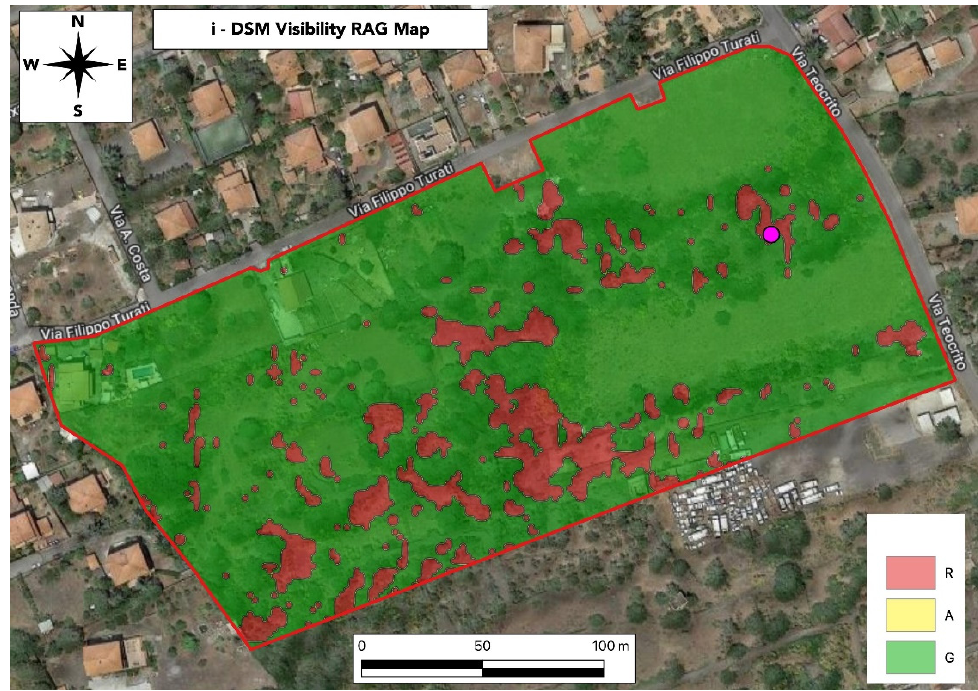
Figure 19. RAG map of the “DSM-based visibility” layer of the GIS platform. The burial site (pink circle) fell on the Red coded area. For the percentages of RAG color-coded areas see Figure 11.